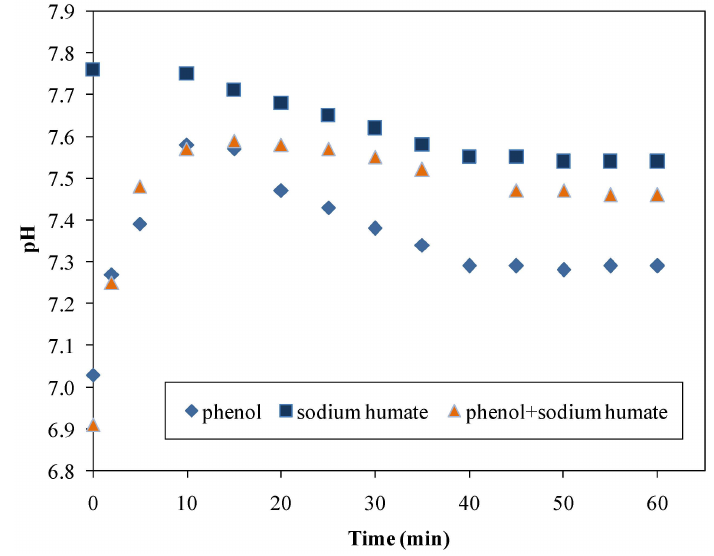
Figure 4. The examination of the pH variation during adsorption in the single pollutant and in the combined